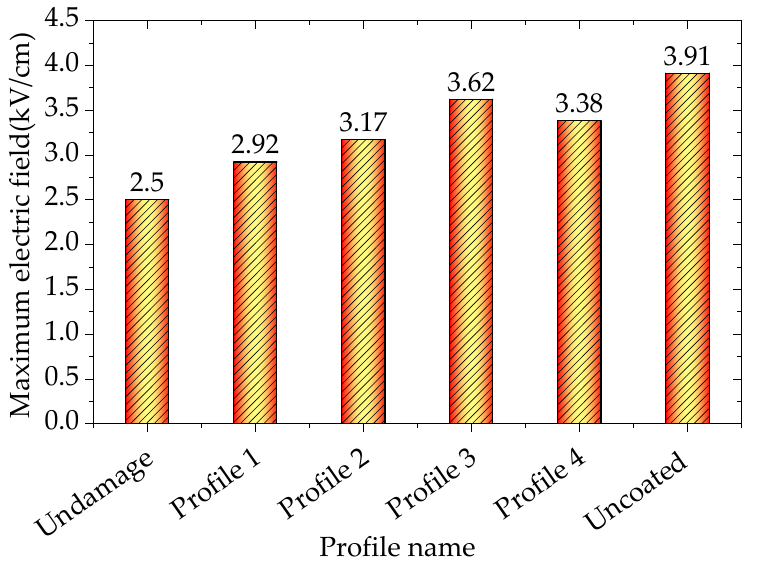
Figure 16. Maximum electric field value at each coating damage profile in the porcelain insulator string.